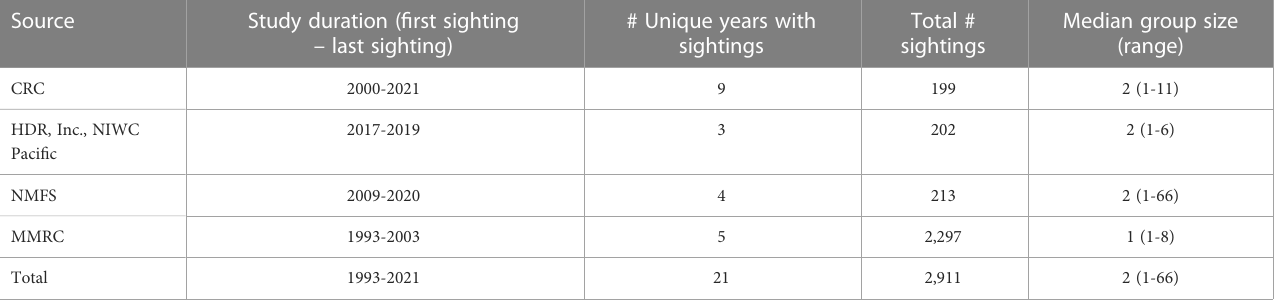
TABLE 3 Humpback whale sighting data during the breeding season (December-May) within the main Hawaiian Islands breeding area perimeter (see Figure 6 ). Source Study duration ( fi rst sighting – last